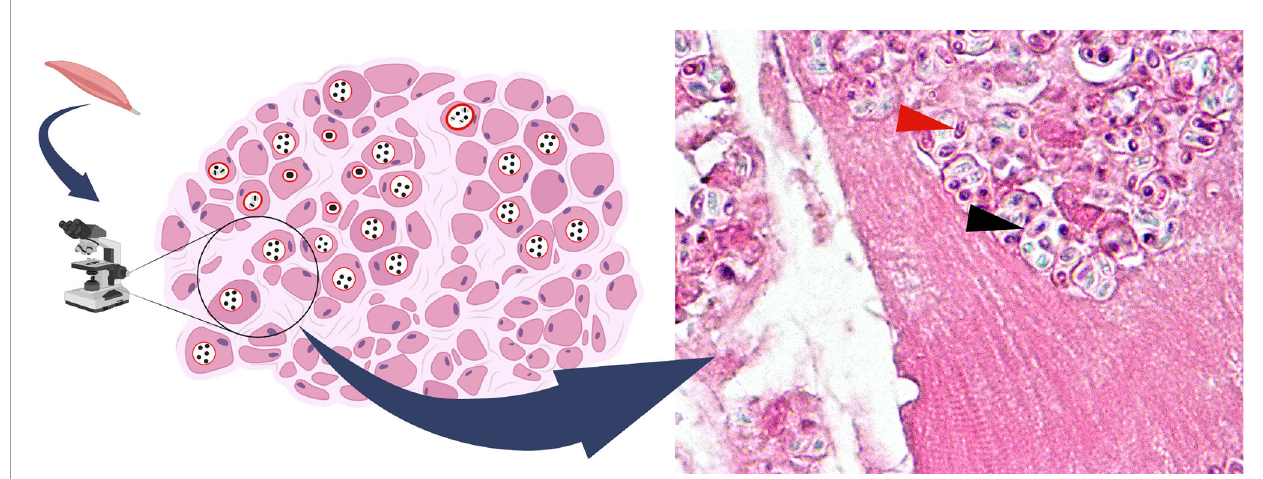
FIGURE 4 | Hematoxylin & eosin stain of T. hominis in skeletal muscle (magni fi cation X1000). Spores observed in circular spaces (parasitophorous vacuoles) in muscle fi ber (black arrow). Spore with a characteristic belt-like stripe (red arrow). This image was created with BioRender